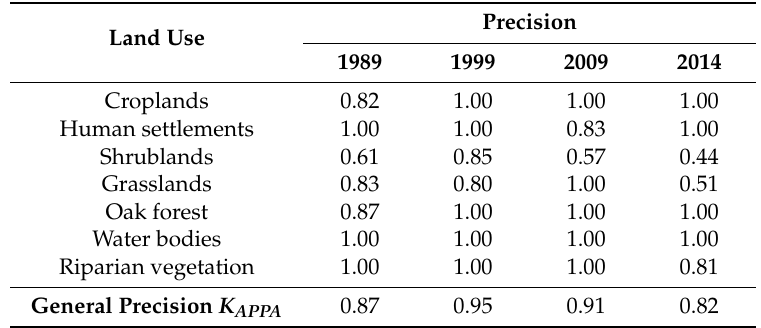
Table 3. Accuracy of the land use